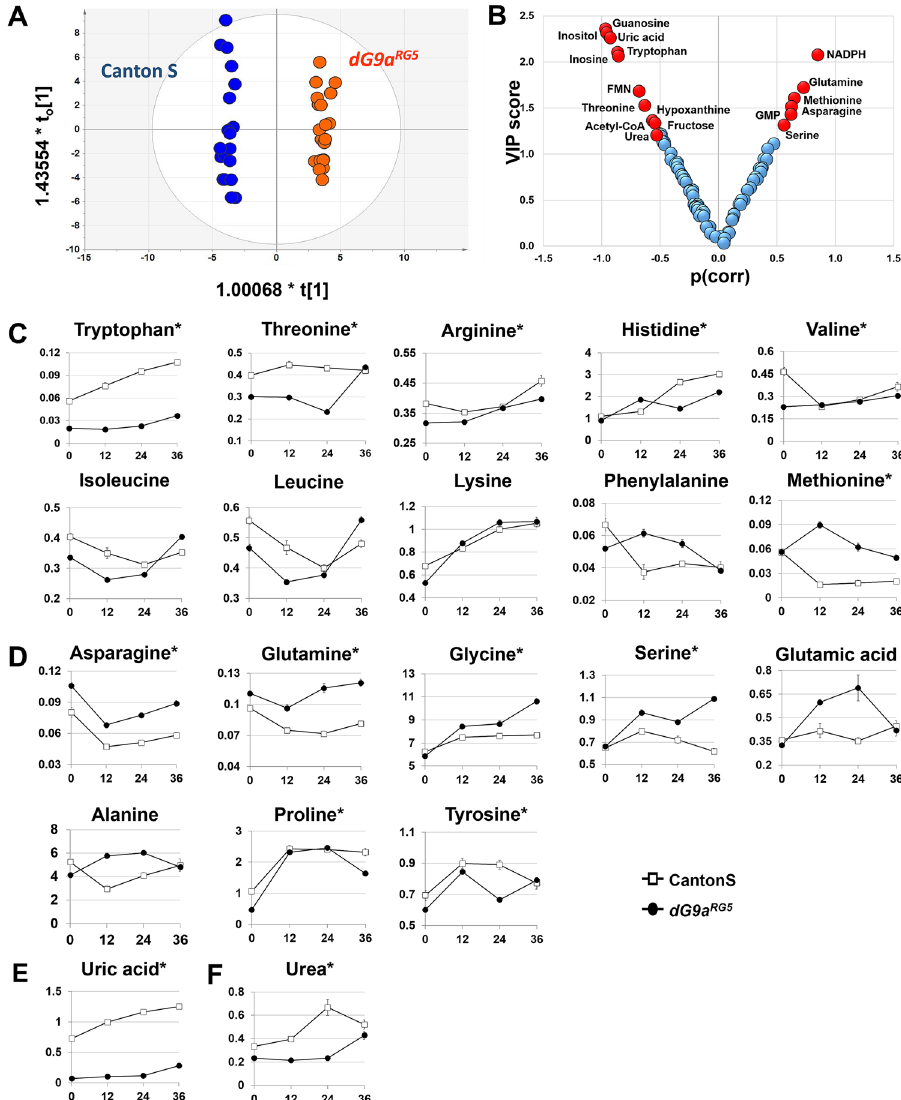
Figure 4. Amino acid metabolism. A general view of the metabolites detected belonging to amino acids including: ( A ) The OPLS-DA score plot showed a clear separation between two genotypes with p(CV- ANOVA) = 1.99925E-23. ( B ) A plot formed by VIP scores and p(corr) revealed using OPLS-DA. The criteria VIP > 1.0 and |p(corr)| > 0.5 were used to select potential metabolites (red) showing marked changes due to the loss of dG9a. ( C ) Essential amino acids ( D ) Non-essential amino acids ( E ) Uric acid ( F ) Urea. 4–5 replications for each time point. * The metabolites were significantly different in “genotype” between the wild-type and dG9a RG5 mutant in a two-way ANOVA with P <